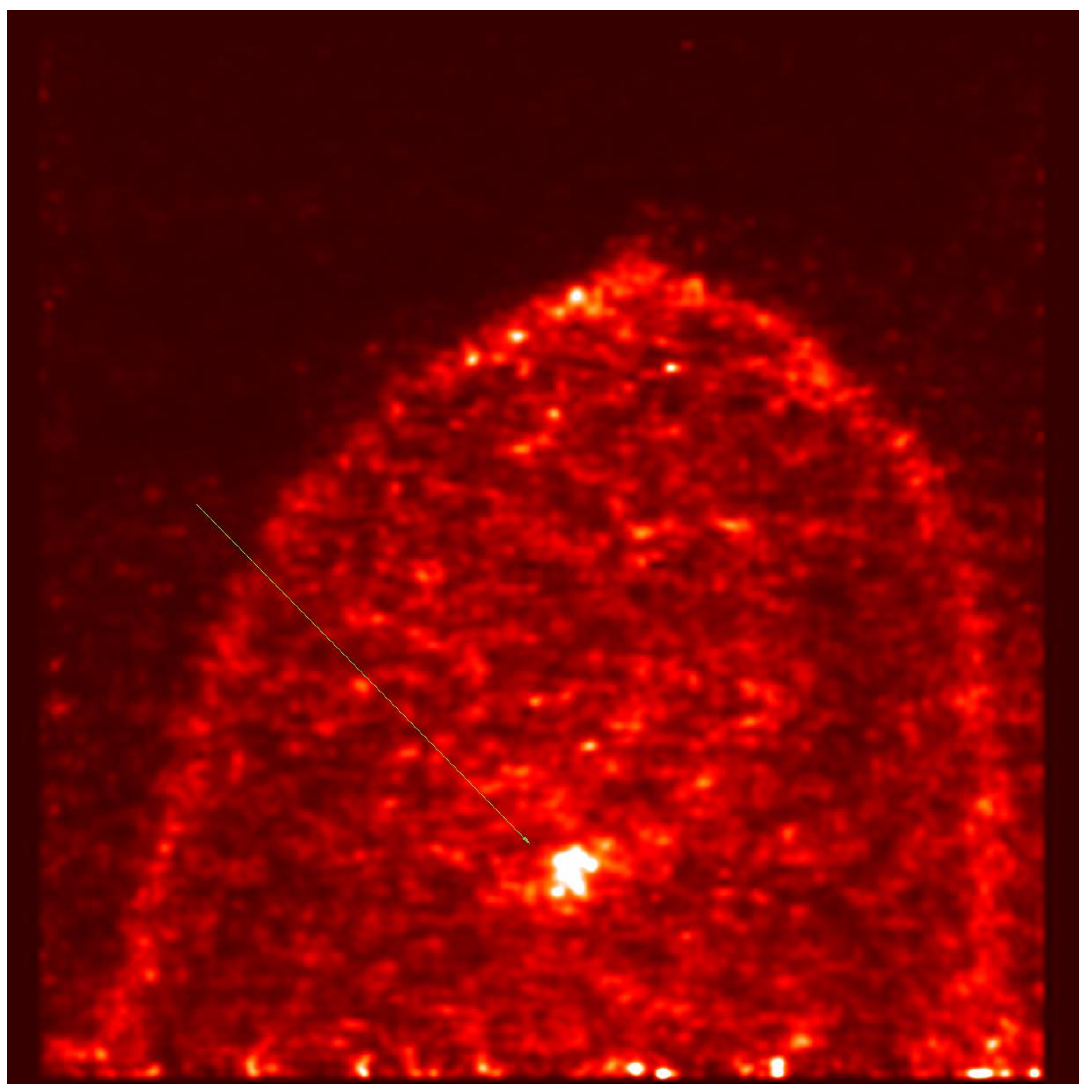
Figure 3. PET-MAMmography with Molecular Imaging (MAMMI) and prone positron emission tomography-computed tomography (PET-CT) performance against malignant and benign biopsy- proven lesions .